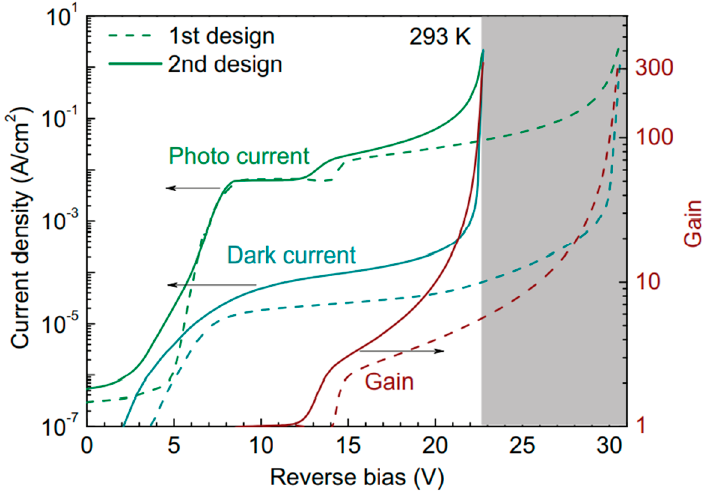
Figure 32. Dark- and photo-current characteristics (left axis) and multiplication gain (right axis) of different charge-layer designs. Reproduced with permission from [87], WILEY-VCH, 2016.